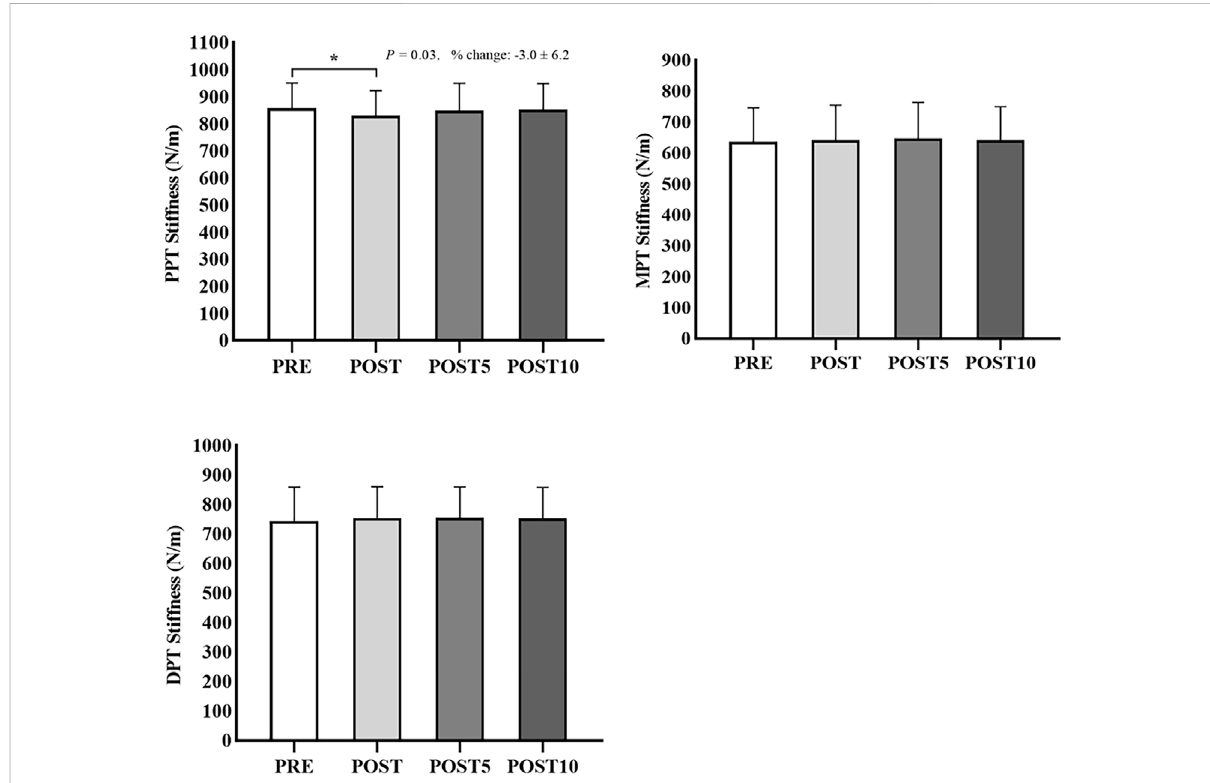
FIGURE 4 Stiffness changes of the proximal (PPT), middle (MPT), and distal (DPT) regions of the patellar tendon before (PRE) and immediately after static stretching (POST), or 5 (POST 5) and 10 (POST 10) min after static stretching. p p <